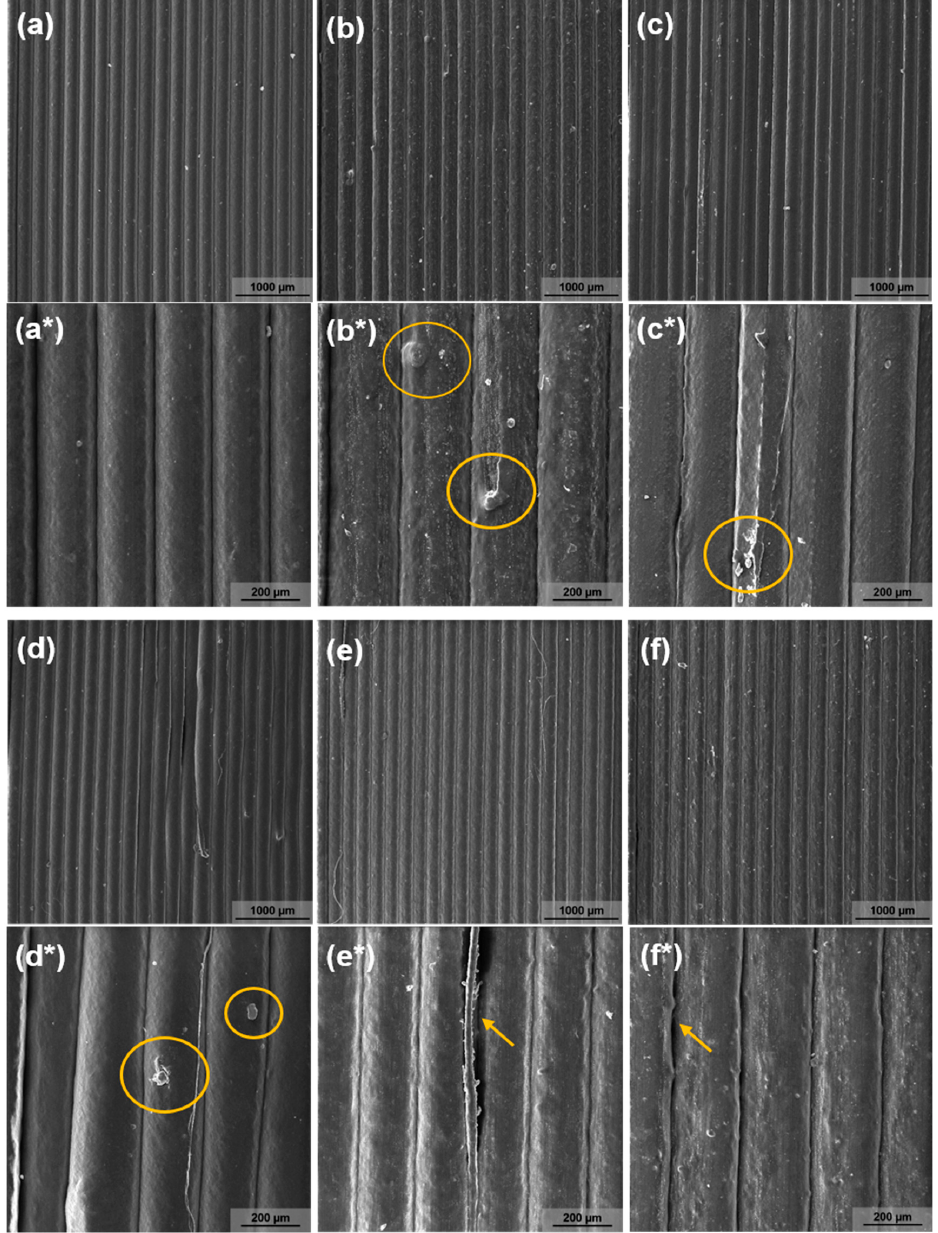
Figure 2. SEM micrographs of the external surface of a 3D printed sample for different compositions and magnifications: 50× [( a ) Ecov, ( b ) Ecov/3NPK, ( c ) Ecov/3bent, ( d ) Ecov/6bent, ( e ) Ecov/3Bent/3NPK and ( f ) Ecov/6bent/3NPK]; 200× [( a* ) Ecov, ( b* ) Ecov/3NPK, ( c* ) Ecov/3bent, ( d* ) Ecov/6bent, ( e* ) Ecov/3Bent/3NPK and ( f* ) Ecov/6bent/3NPK]. The micrographs indicate that there was a good filler/matrix interfacial interaction. It is believed that the composites surface roughness may be associated to evaporation of water or other substances present in inorganic components, generally associated with their ability to interact with ambient humidity [10,40]. All samples exhibited approximately 200-micrometer thick layers, conforming to the layer height standard (0.2 mm) set at printing. Despite some observed discontinuities, all samples showed geometric